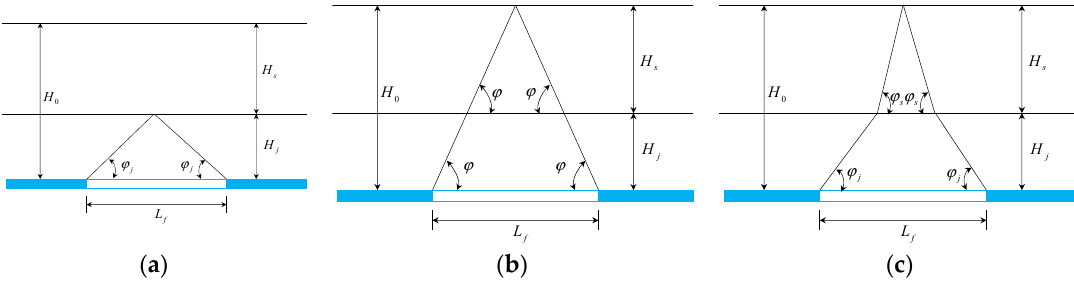
Figure 6. Calculation model of critical dimension for full mining: ( a ) bedrock decision method; ( b ) comprehensive impact parameter method; ( c ) dual-medium method.